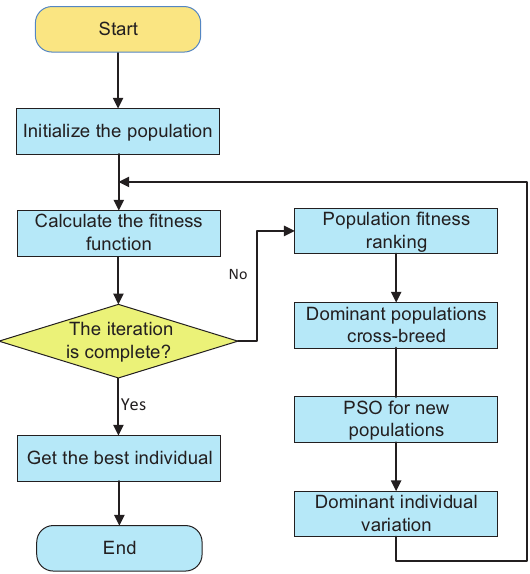
Figure 6. The grid map matching algorithm based on PSO-GA.